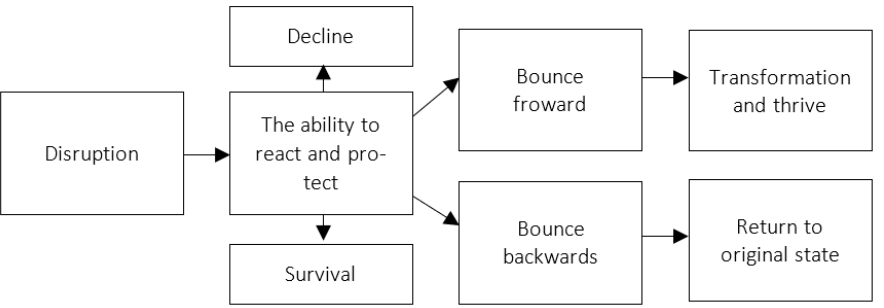
Figure 1. Transformations of organisational resilience (OR). Source: authors’ elaboration based on literature review (see [10,34,39,47,53]).